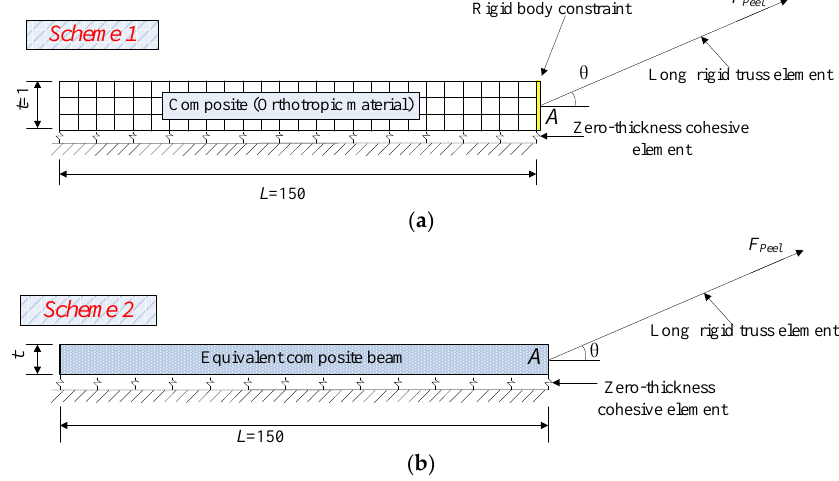
Figure 4. Illustration of the finite element (FE) model of the peeling test (unit: mm): ( a ) Orthotropic 4- node plane stress element; ( b ) 2-node linear elastic beam element.